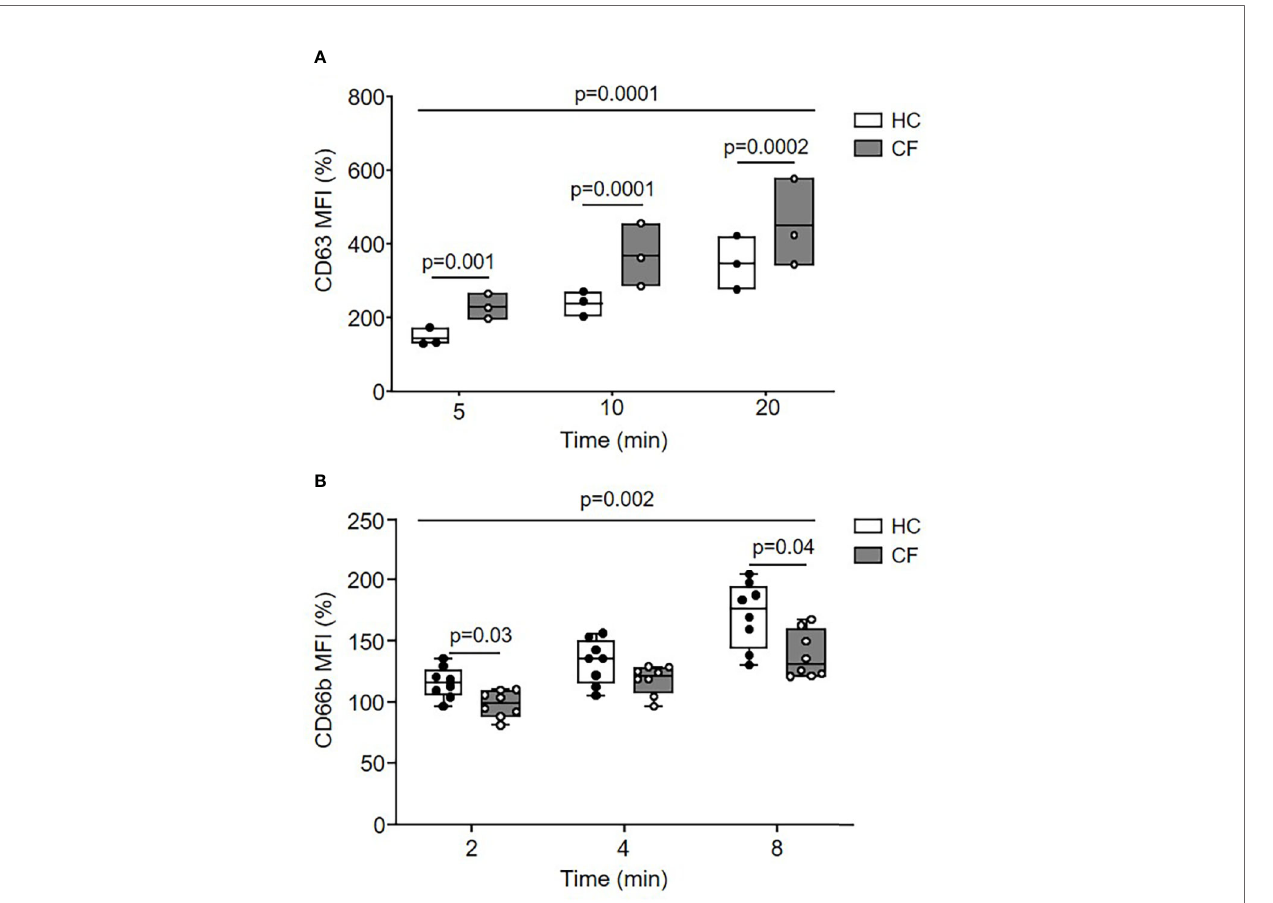
FIGURE 2 | Dysregulated movement of granular proteins to phagosomes of neutrophils from PWCF. (A, B) Phagosomes were isolated following phagocytosis of IgG opsonized latex particles. Phagosomal membrane levels of CD63 (A) or CD66b (B) were quanti fi ed by fl ow cytometry and expressed as mean fl uorescence intensity (MFI). Compared to HC, CF phagosomes ( Phe508del single copy) displayed signi fi cantly increased levels of CD63 (n = 3 subjects per group, two-way ANOVA with post-hoc S ̌ ı ́ da ́ k test) and signi fi cantly reduced levels of CD66b (n = 8 subjects per group, two-way ANOVA with post-hoc S ̌ ı ́ da ́ k test). Data represent mean percentage change in fl uorescence from time